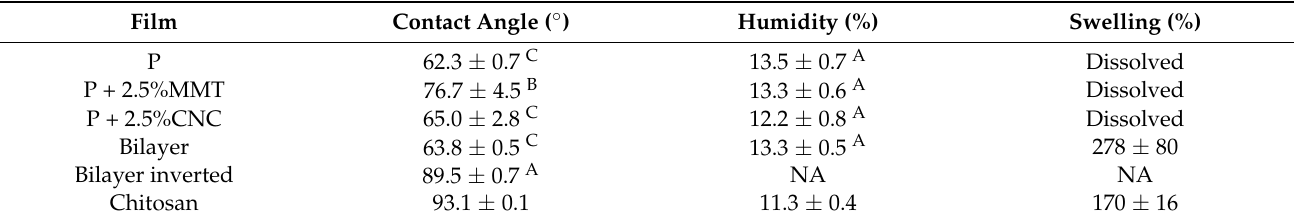
Table 2. Contact angle, swelling and humidity of the